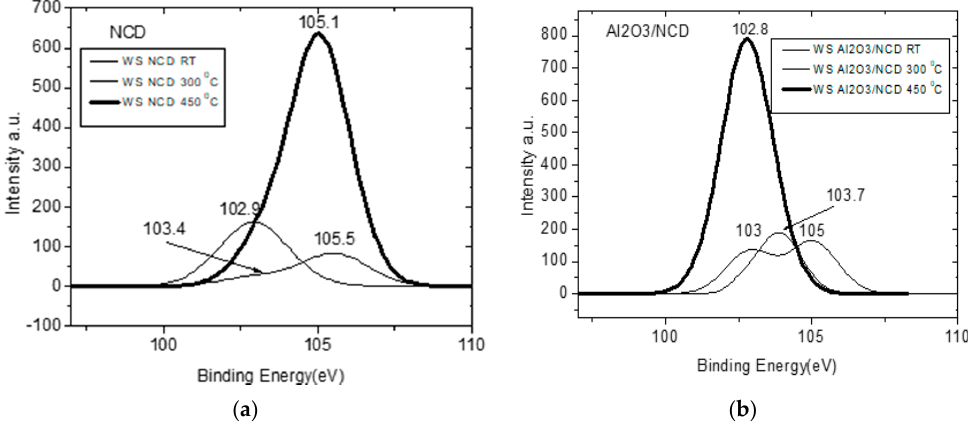
Figure 14. XPS spectra of the Si 2p peak taken on the ( a ) NCD and ( b ) Al 2 O 3 /NCD films. The Raman and XPS spectra taken on the A-Al 2 O 3 /NCD films (not shown) were similar to ones on the Al 2 O 3 /NCD films.